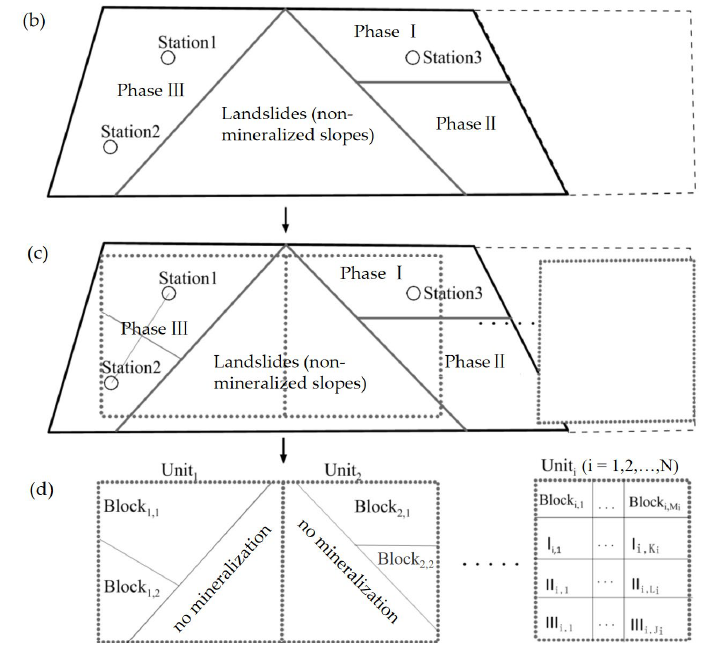
Figure 5. The slope mineralized block segment of the segmented statistical unit: ( a ) statistical units Unit 1 , Unit 2 , and an arbitrary unit Unit i ; ( b ) slope mineralization zones and geological survey stations; ( c ) superposition calculation of statistical units, mineralization zones, geological stations, and other layers; ( d ) Mineralized block segments of statistical units.